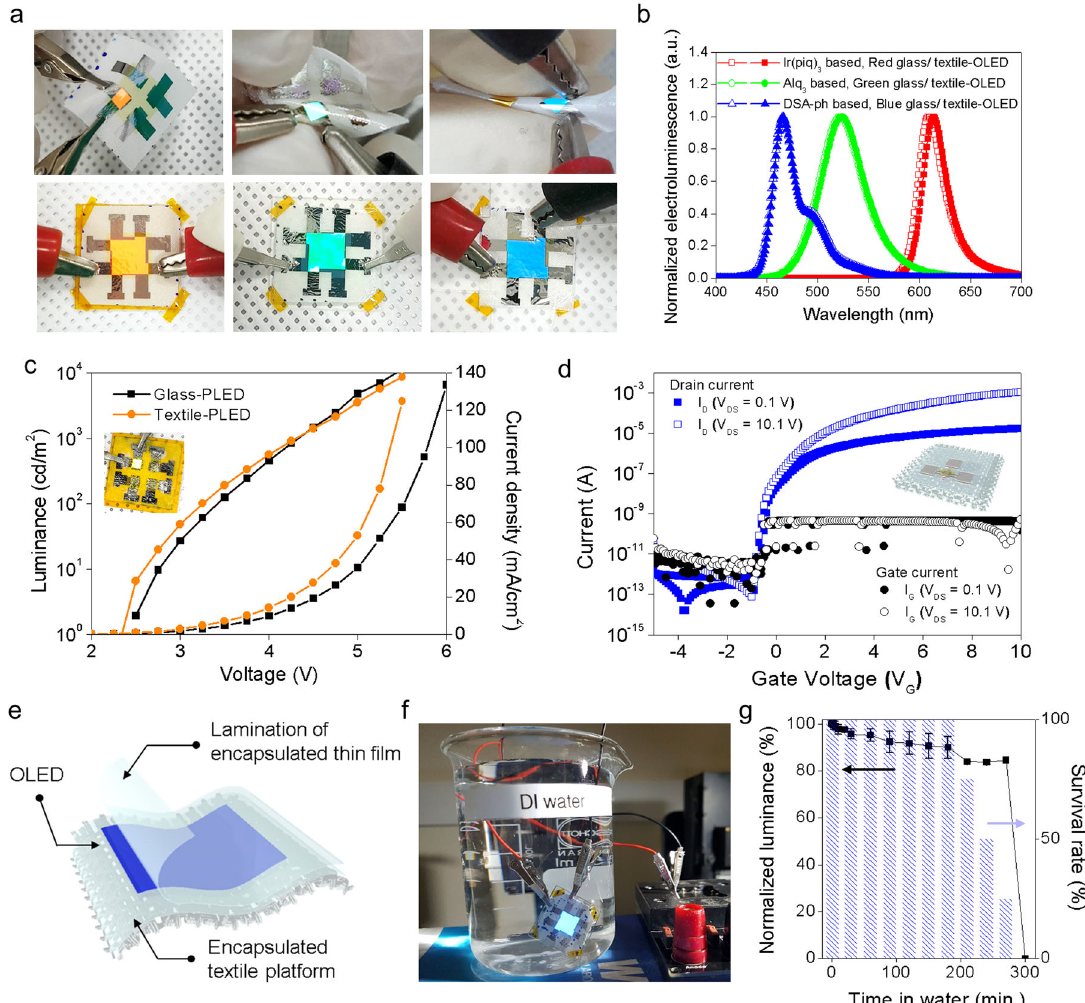
Fig. 4 Element technologies for textile-AMOLED, and wide applicability to various textiles. a The R, G, B colored textile-OLEDs under deformation, and with a wide area of 69 mm 2 . b Normalized electroluminescence of the R, G, B colored glass-OLED and textile-OLED. c Electrical and optical characteristics (JVL) of the glass-PLED and the textile-PLED. d Transfer curve of the textile-TFT (linear mode: V DS = 0.1 V, saturation mode: V DS = 10.1 V). e Schematic diagram of the washable textile-OLED with the water-resistant encapsulation. f Photograph of the washable textile-OLED operating in DI water. g Changes in luminance over time (the initial luminance: 1000